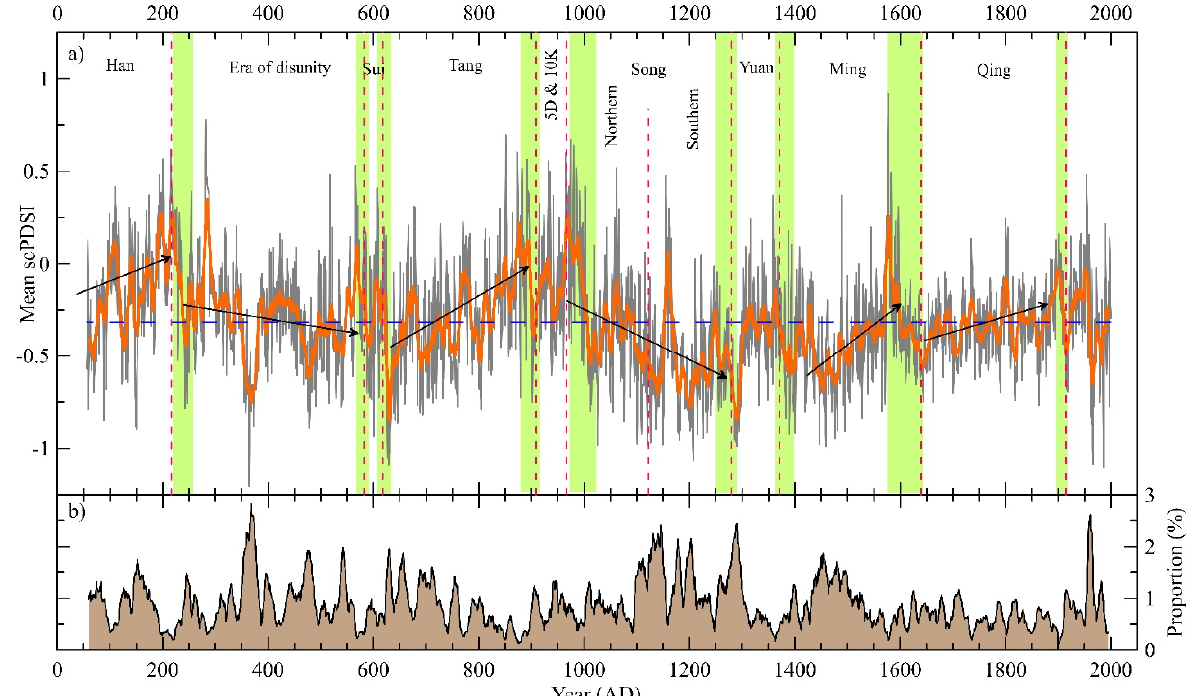
Figure 6. ( a ) The mean scPDSI interannual variation curve of China during the past two millennia (AD 56–2000). The gray line represents the annual mean value of the reconstructed scPDSI of whole of China. The orange line represents the 10-year moving average value of the reconstructed scPDSI of the whole of China. The black dashed line represents the perennial average value of the reconstructed scPDSI of the whole of China. The vertical pink dashed lines are dynasty dividing lines. ( b ) Proportion diagram of severe drought events (scPDSI ≤ −3, Table 1).